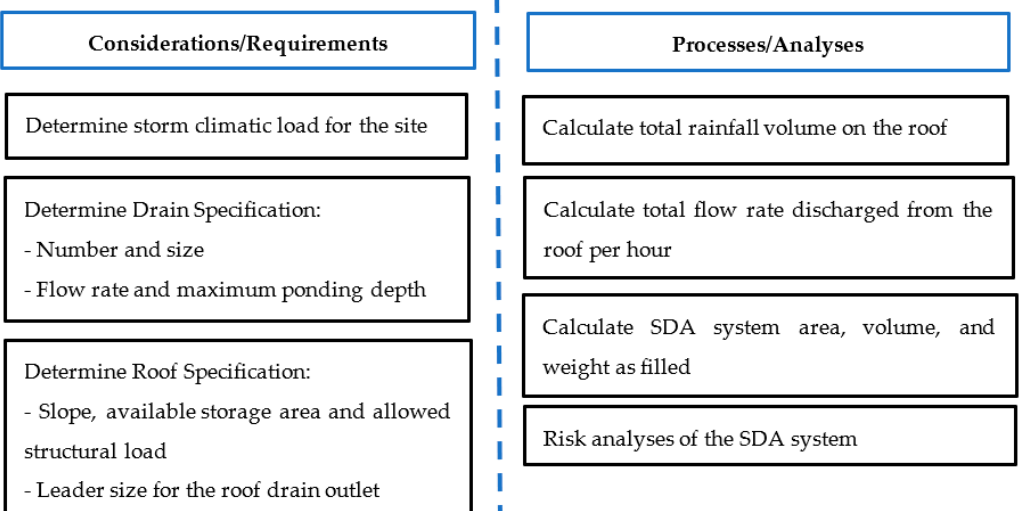
Figure 6. SDA design consideration/requirements and processes and analyses.